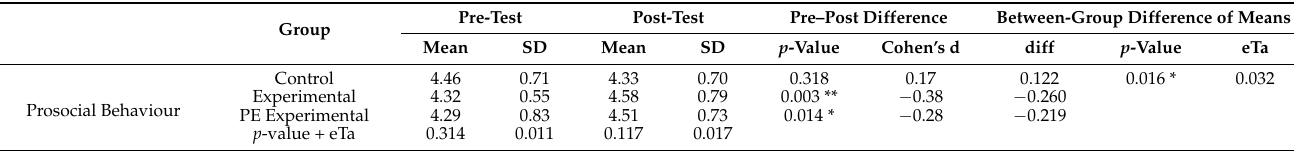
Table 7. Prosocial behaviour results.